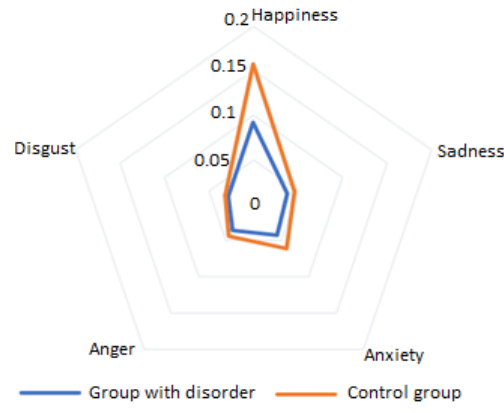
Figure 2. Profiles of a healthy and sick person are shown on a radar chart (the values of the intensity of emotions range from 0 to 1, where 0 means that there is no emotion in the note, and 1 the maximum value of emotion in the